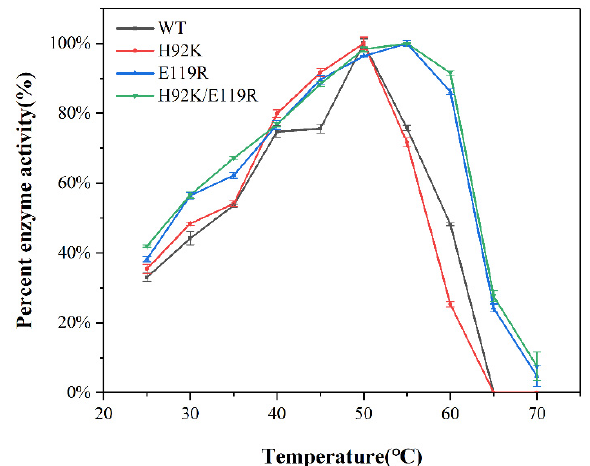
Figure 6. The optimal temperature of WT, H92K, E119R, and H92K/E119R was measured, reacted at 25–70 °C for 10 min, and three sets of enzyme activity data were tested every 5 °C. The value of each data point represents the average value. Table 1. K m , V max , and K cat /K m of WT and mutants on mannose.